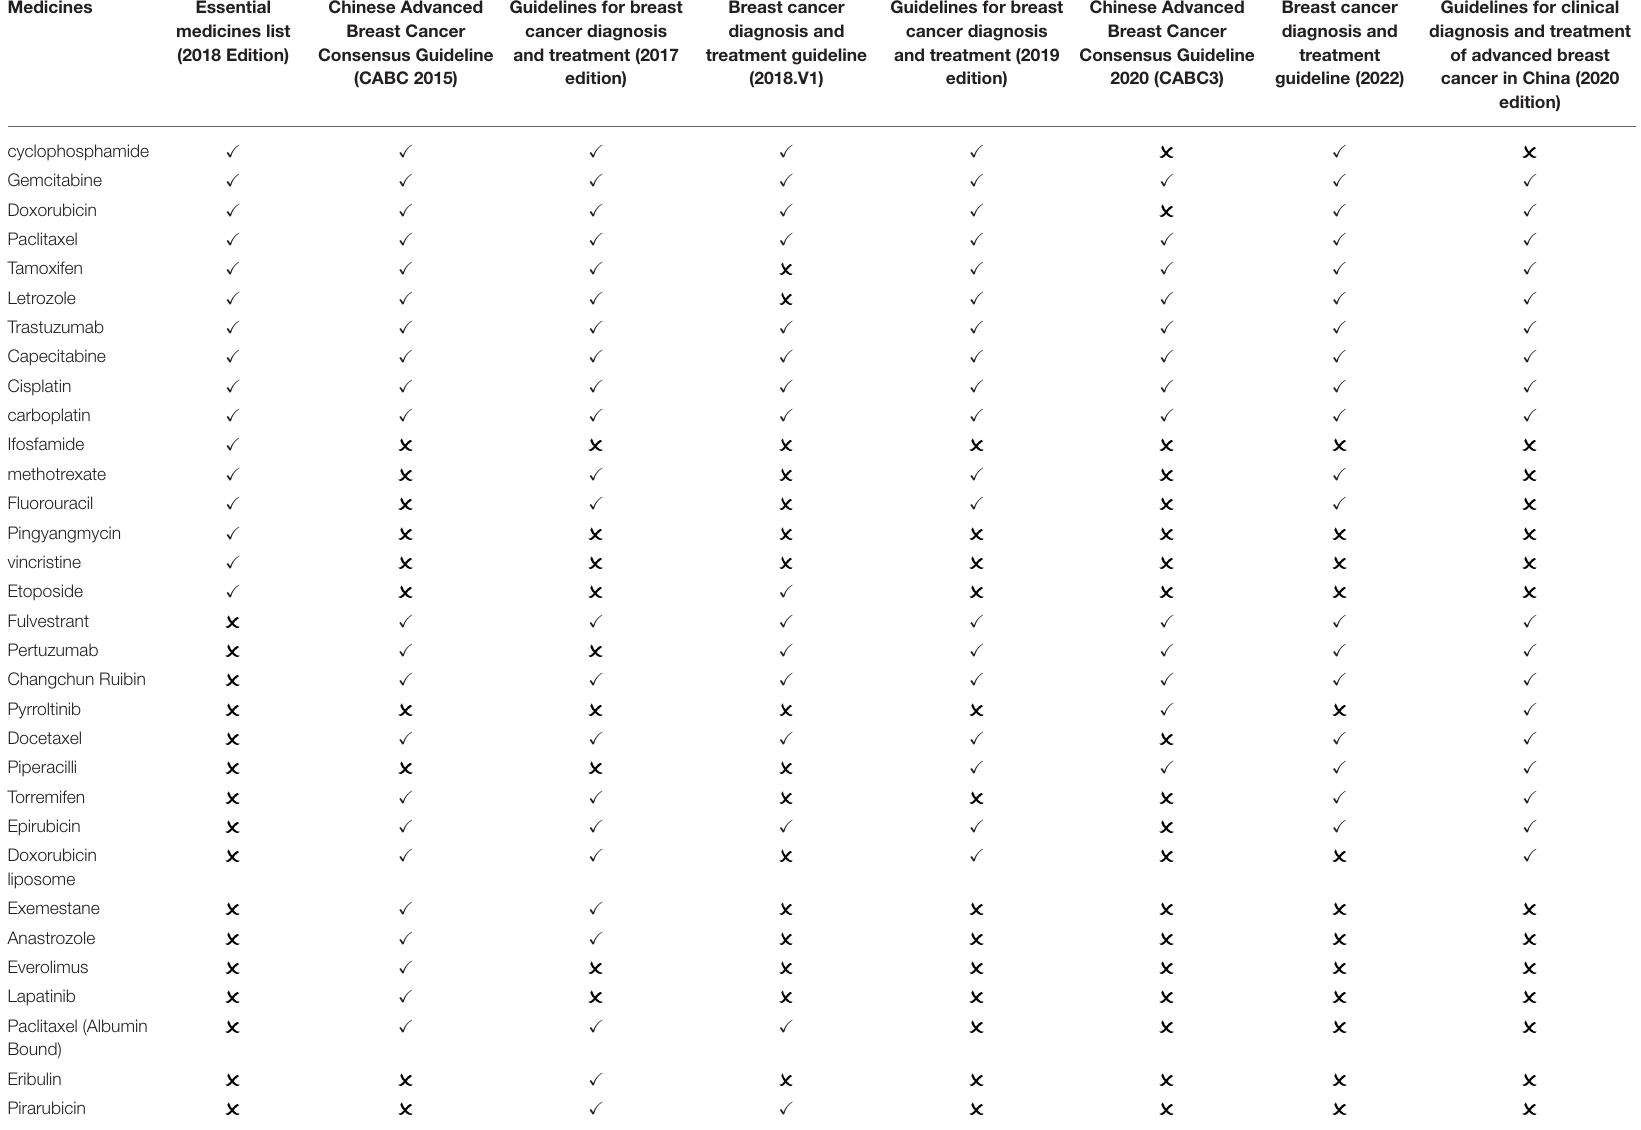
TABLE 2 | Medicines in the list and guidelines for the treatment of breast cancer. Medicines Essential medicines